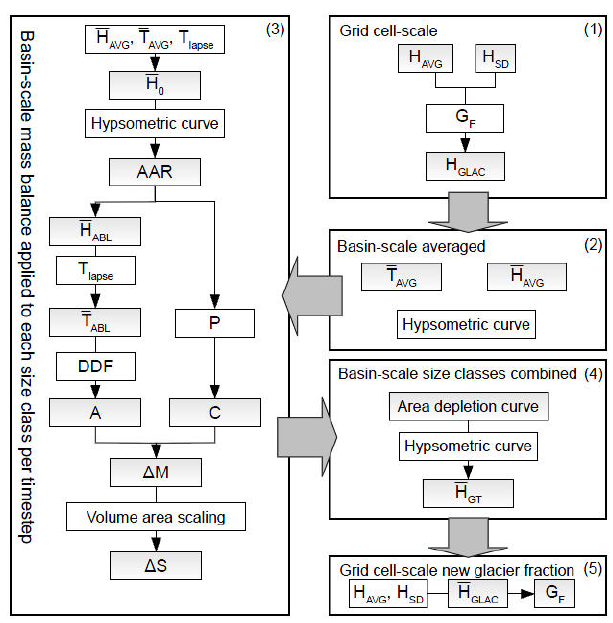
Fig. 4. Schematic representation of glacier modeling steps. First cal- culations are made at the 1km grid cell scale (1). Using the grid Figure 4. Schematic representation of glacier modeling steps. First calculations are made at 3 cell’s mean terrain elevation ( H AVG ) in combination with the stan- the 1 km grid cell scale (1). Using the grid cell’s mean terrain elevation ( H ) in 4 dard deviation of terrain elevation within the grid cell ( H SD ) and the AVG fractional glacier cover of the grid cell ( G F ), the median elevation combination with the standard deviation of terrain elevation within the grid cell ( H ) and 5 SD of the part of the grid cell that is covered by ice can be determined G ), the median elevation of the part of the grid 6 the fractional glacier cover of the grid cell ( ( H GLAC ). Basin scale averaged temperature and elevation for grid F cells with glaciers ( T AVG and H AVG ) are calculated (2). Values of H ). Basin scale averaged temperature and 7 cell that is covered by ice can be determined ( GLAC H GLAC for all grid cells from step 1 are used to construct a basin elevation for grid cells with glaciers ( T and H ) are calculated (2). Values of H for 8 AVG AVG GLAC scale hypsometric curve.Basin scale mass balance calculations are all grid cells from step 1 are used to construct a basin scale hypsometric curve. Basin scale 9 done for all glaciers in 26 glacier size classes with a monthly time step (3). Using H AVG , T AVG and a temperature lapse rate ( T lapse ) mass balance calculations are done for all glaciers in 26 glacier size classes with a monthly 10 the basin scale 0 ◦ C isotherm can be determined ( H 0 ). By com- time step (3). Using H , T and a temperature lapse rate ( T ) the basin scale 0 ºC 11 AVG AVG lapse bining H 0 with the hypsometric curve the accumulation area ratio isotherm can be determined ( H ). By combining H with the hypsometric curve the 12 (AAR) can be calculated. With the AAR the amount of ablation ( A) 0 0 and accumulation ( C) can be derived. A representative temperature for the ablation zone ( T ABL ) is calculated at the mean elevation of the ablation zone ( H ABL ). A degree day factor (DDF) is used to cal- culate the actual ablation. The accumulation consists of the precip- itation ( P) over the accumulation zone. Using A and C a monthly mass balance ( 1M) is calculated. Applying volume-area scaling in October each year an updated glacier area is calculated for the glaciers in each size class and the change in area can be tracked ( 1S) . With the result from step 3 a basin scale area depletion curve is constructed to derive an updated basin scale median elevation of the glacierized part of the basins ( H GLAC ) for each month (4). With H GLAC and the elevation distribution within a grid cell (mean ter- rain elevation ( H AVG ) and standard deviation of elevation ( H SD )), the basin scale model output is downscaled to the grid cell scale for each month, to provide an updated fractional glacier cover ( G F ) per grid cell (5).